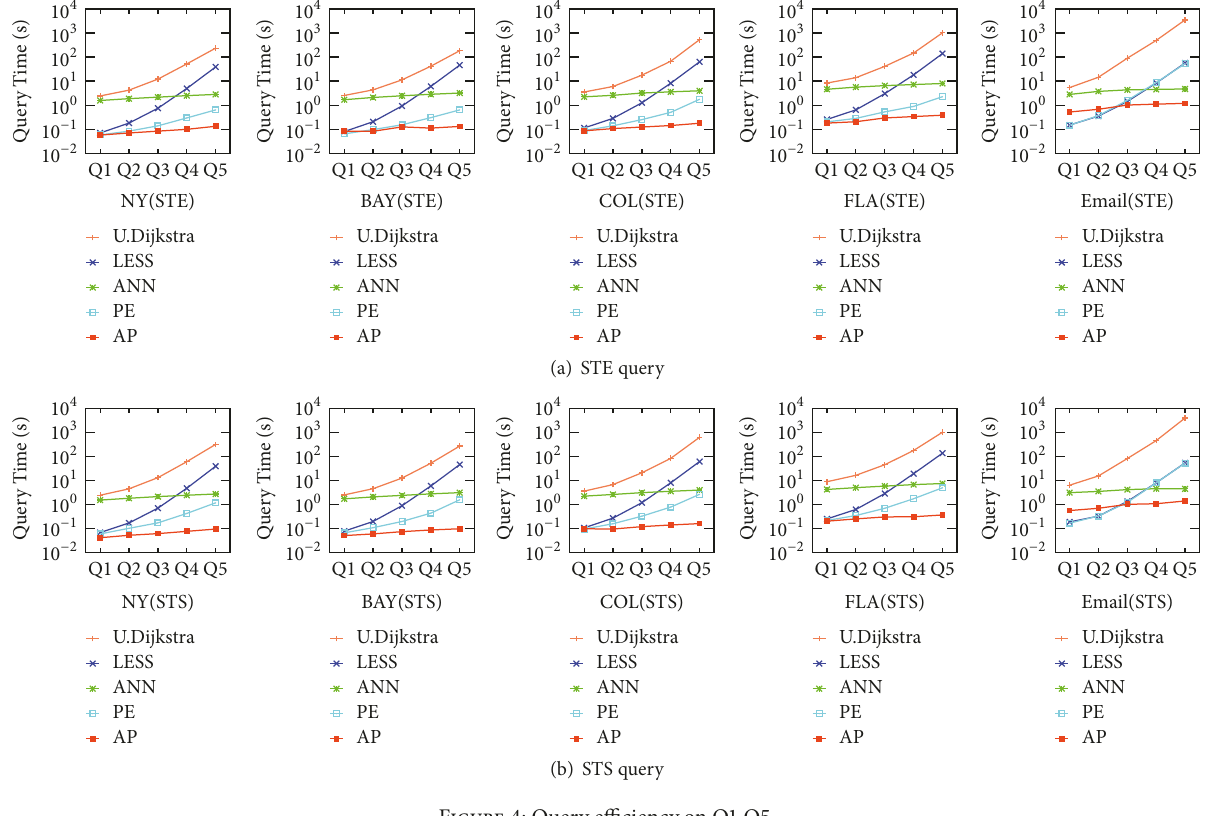
Figure 4: Query efficiency on Q1-Q5.